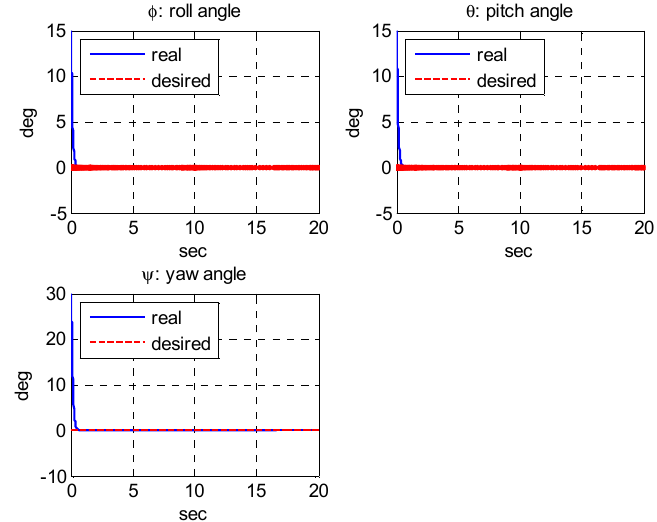
Figure 3. The attitude path with variable deviations.